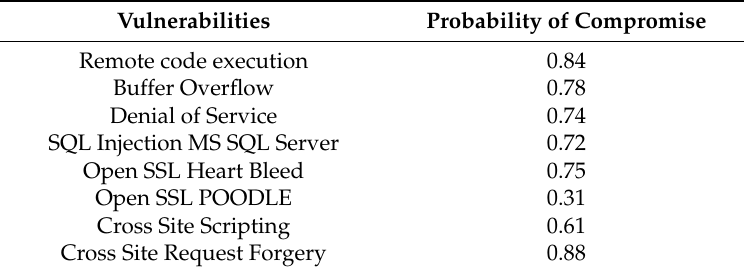
Table 1. Probability of compromise using the CVSS online base